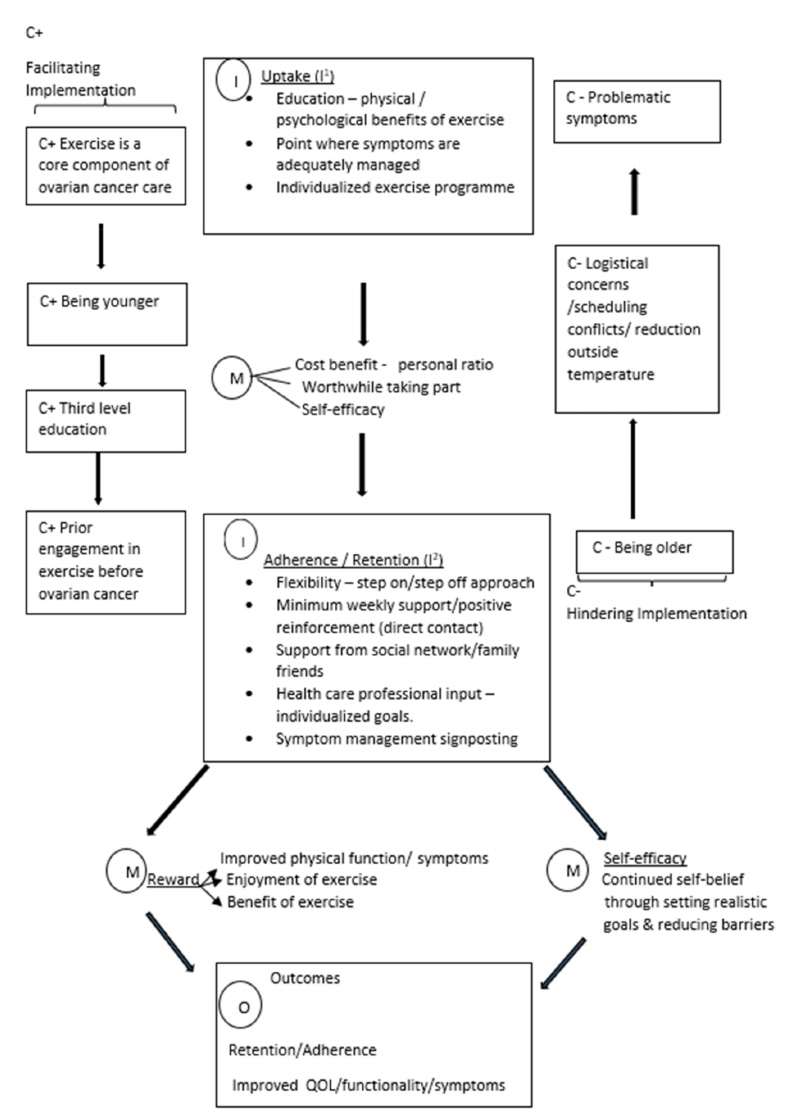
Figure 2. Theoretical model of how exercise interventions for women with ovarian cancer are thought to